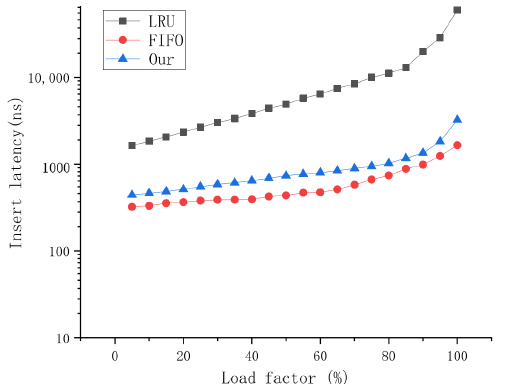
Figure 8. Insert latency of different cache replacement algorithms under different load factors in the